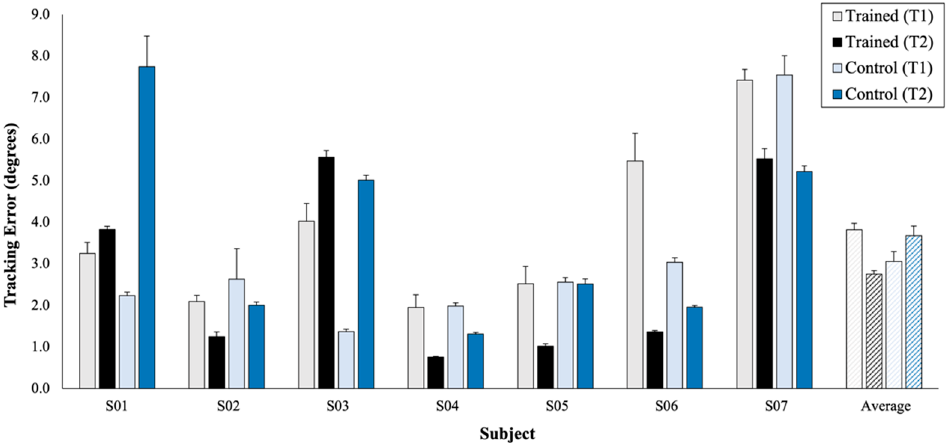
Figure 3. Median tracking error (degrees) comparing the trained (black/grey) and control (colors) limbs at T0 and T1. The amount of tracking error significantly decreased from T0 to T1 ( p = 0.03).